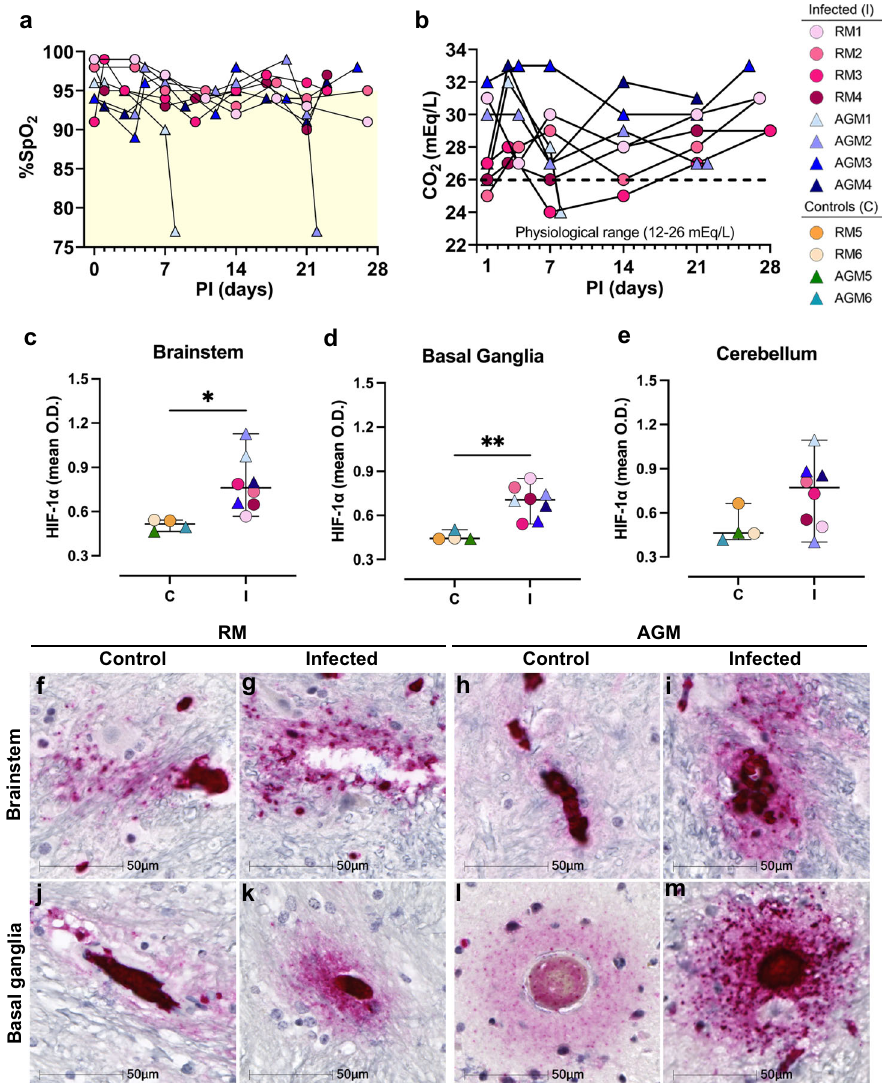
Fig. 5 Reduced blood oxygen may contribute to brain hypoxia in SARS-CoV-2 infection. SARS-CoV-2 infection was associated with lower blood oxygen levels ( a ) and increased blood carbon dioxide ( b ). Yellow shading denotes a lower than physiological range of SpO 2 . HIF-1a expression appeared to be upregulated by cells comprising the vasculature and extended into the parenchyma in the context of infection. Expression was signi fi cantly greater than age-matched mock-infected control animals in ( c ) brainstem, * p = 0.0154 (95% CI = 0.06550 – 0.4895) control vs. infected animals and ( d ) basal ganglia, ** p = 0.0016 (95%CI = 0.1149 to 0.3621) control vs. infected animals. Signi fi cant difference was not seen in ( e ) cerebellum ( n = 4 biologically independent samples in the control group, and n = 8 biologically independent samples in the infected group). Statistics were performed with unpaired two- tailed t test, df = 10. Data are expressed as mean ± SEM. When separated by species, statistical signi fi cance is retained in the basal ganglia but not brainstem (Supplementary Data Fig. 7). Representative images show low HIF-1 α expression in brainstem of mock-infected animals, RM5 ( f ) and AGM5 ( h ), as well as basal ganglia of RM6 ( j ) and AGM5 ( l ). In comparison, HIF-1a is upregulated in brain of infected animals. Representative images include brainstem of RM3 ( g ) and AGM4 ( i ) and basal ganglia of RM3 ( k ) and AGM1 ( m ). Immunohistochemical staining for HIF-1 α was performed thrice on the brain regions investigated. Source data are provided as a Source Data fi le. Abbreviations: PI post-infection. O.D. optical density, %SpO 2 blood oxygen saturation, AGM African green monkey, RM Rhesus macaque, C control, I infected. Scale bars = 50 µ